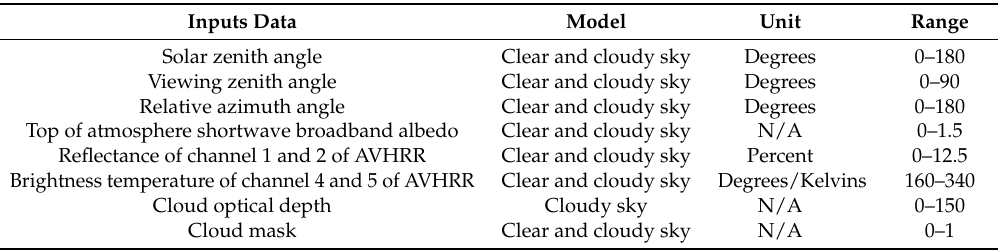
Table 1. Input settings of the GBRT-based downward shortwave radiation (DSR) clear and cloudy sky